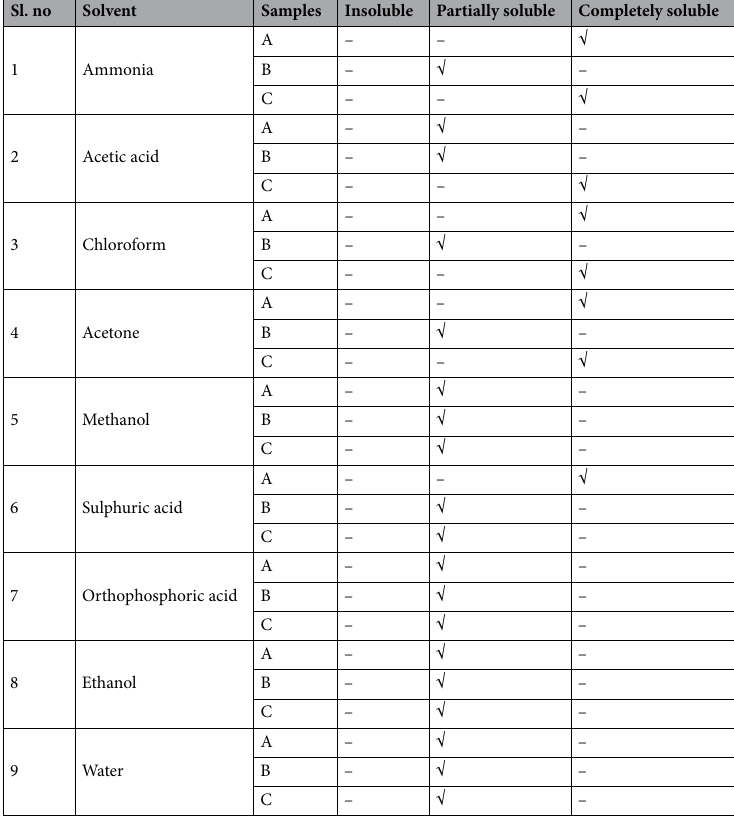
Table 1. Shows the solubility test results of all samples soaked in a different solvent